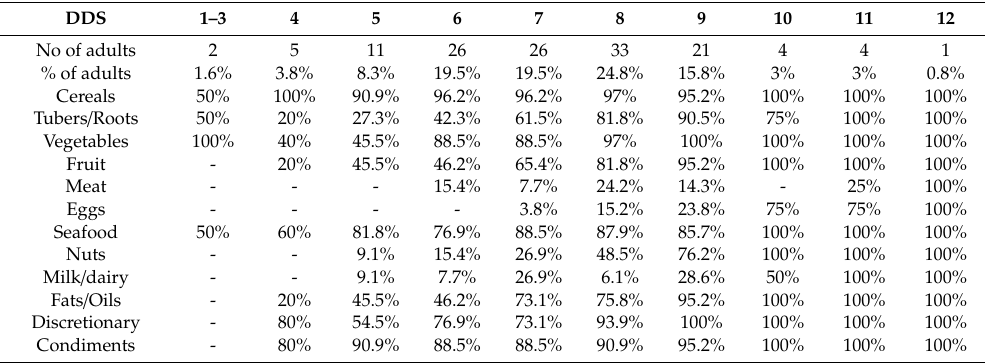
Table 3. Proportion of consumption from di ff erent food groups by dietary diversity score.